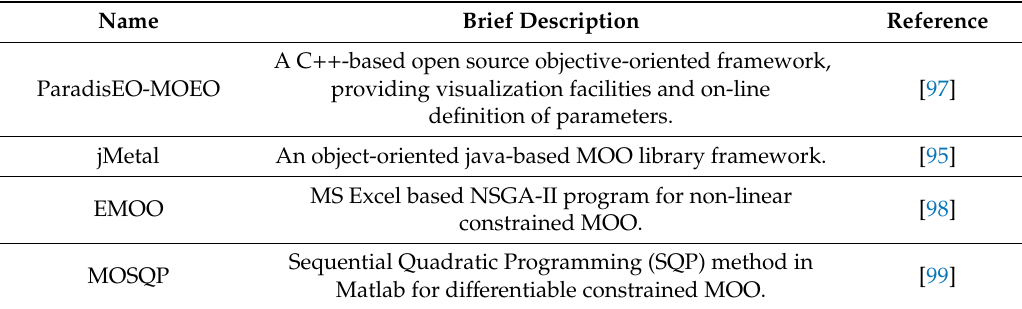
Table 4. Some available software for solving MOO